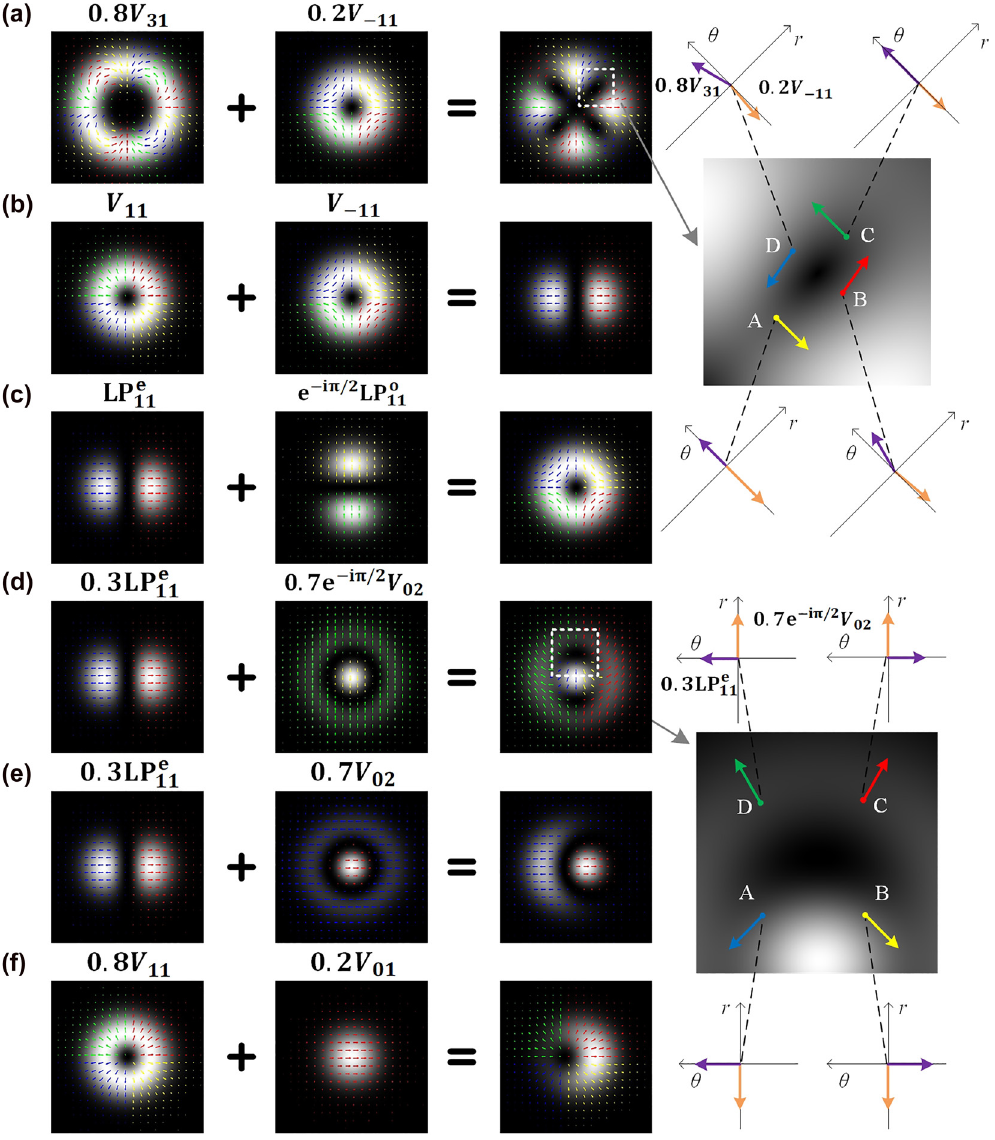
Figure 4: Superimposed patterns of two structured lights with auxiliary arrows indicating complex vectors. Structured lights consist of (a) 0 . 8 V 31 and 0 . 2 V − 11 , (b) V 11 and V − 11 , (c) LP e graphs are the enlarged images framed by the white box of (a) and